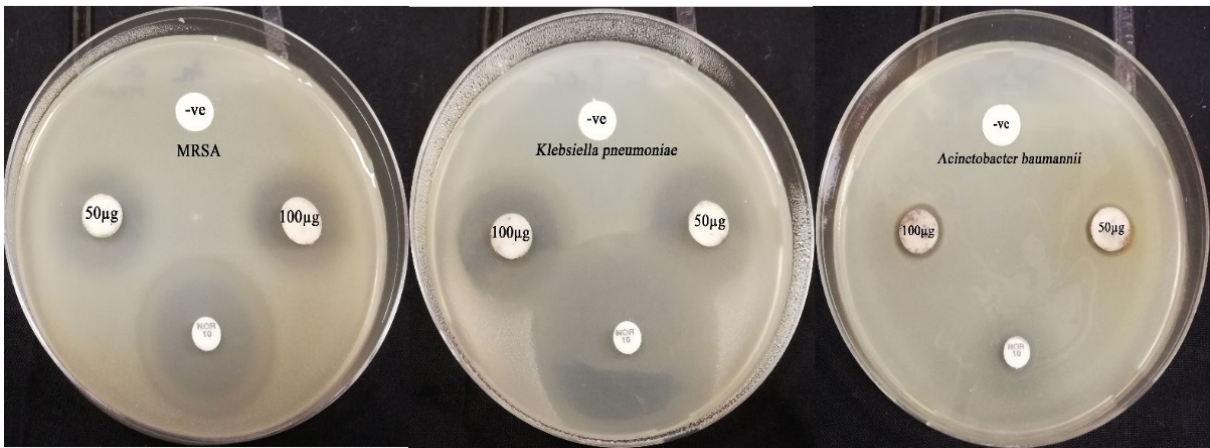
Figure 10. Antibacterial activity of AgNPs against the concerned bacterial pathogens. Table 3. Antibacterial efficiency of AgNPs against different bacterial strains.